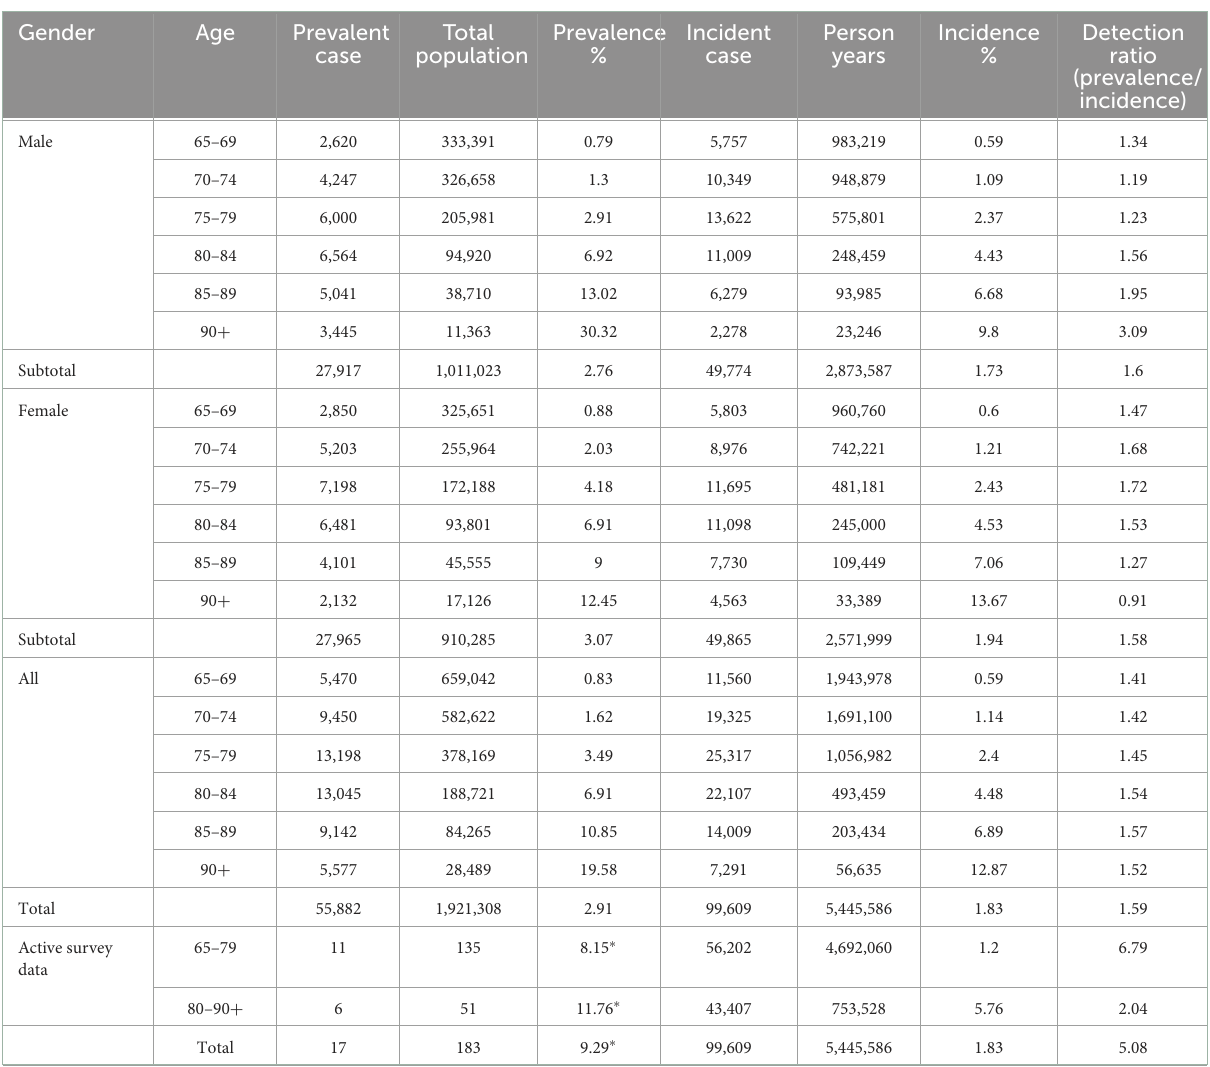
TABLE 1 Age and gender specific prevalence and incidence rate of dementia. Gender Age Prevalent